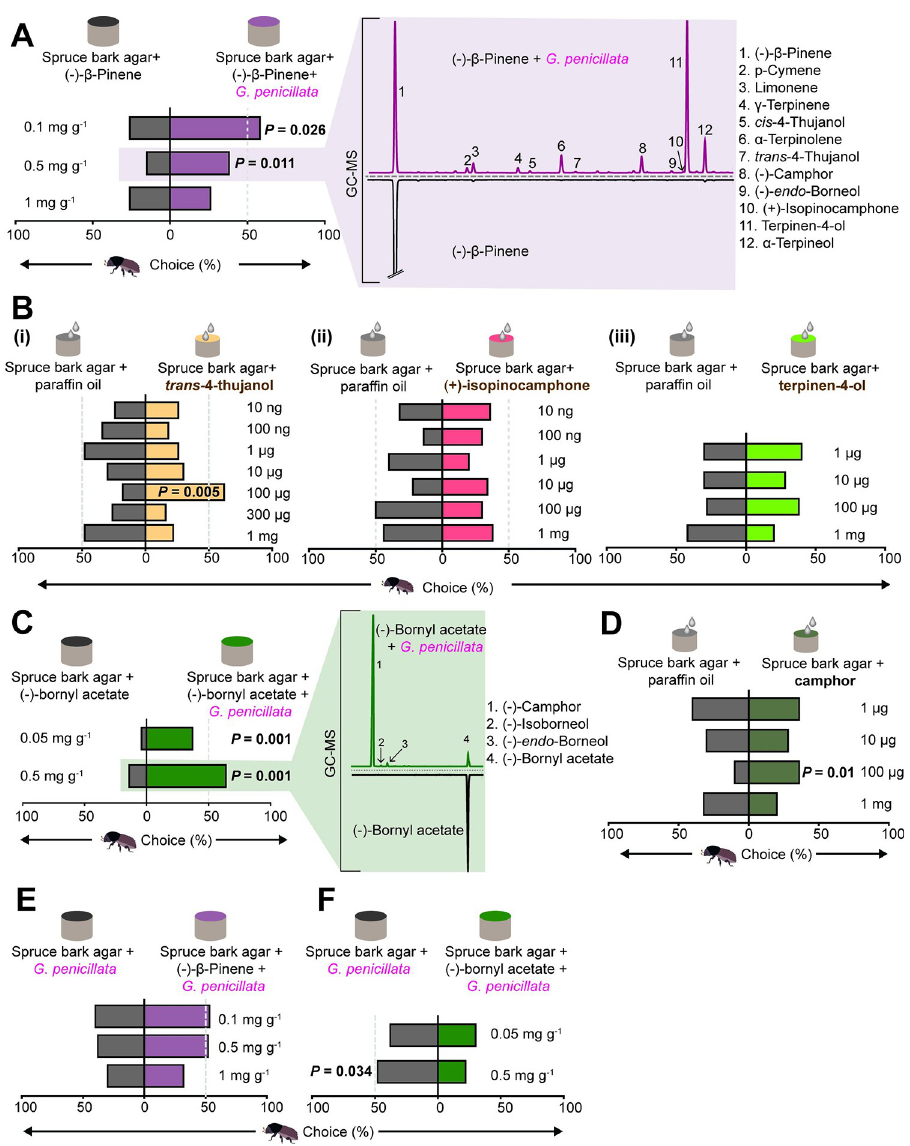
Fig 6. Ips typographus is attracted to a fungal symbiont that produces a blend of oxygenated monoterpenes. (A) Adult beetles preferred spruce bark agar enriched with 0.1 and 0.5 mg/g of ( − )- β -pineneand inoculated with G . penicillata over spruce bark agar enriched with 0.1 and 0.5 mg/g ( − )- β -pinene alone, but without fungus (left). GC–MS traces depict the headspace volatiles of ( − )- β -pinene-enriched agar left for 4 d with and without G . penicillata (right) and show several oxygenated monoterpenes produced by the fungus from ( − )- β -pinene.Numbers refer to the identities of compounds. (B) Adult beetles chose trans -4-thujanol (left) at a 100- μ g dose diluted in mineral oil, when tested against a mineral oil control (Bonferroni adjusted significance level, α = 0.007). Adult beetles showed indifferent responses to (+)-isopinocamphone (middle), and terpinen-4-ol (right), applied in various doses in mineral oil. (C) Adult beetles preferred spruce bark agar enriched with various amounts of ( − )-bornyl acetate and inoculated with G . penicillata over spruce bark agar enriched with ( − )-bornyl acetate but without fungus (left). GC–MS traces depict the headspace volatiles of 0.5 mg/g ( − )-bornyl acetate-enriched agar left for 4 d with and without G . penicillata (right) and show several oxygenated monoterpenes produced by the fungus from ( − )-bornyl acetate. Numbers refer to the identities of compounds. (D) Adult beetles preferred ( ± )-camphor at a 100- μ g dose against a mineral oil control, but not at other doses (Bonferroni adjusted α = 0.012). (E) Adult beetles did not discriminate between G . penicillata on agar with three different concentrations of ( − )- β -pinene and G . penicillata without ( − )- β -pinene. (F) Adult beetles chose G . penicillata on agar without any administrated ( − )-bornyl acetate vs. G . penicillata on agar with 0.5 mg/g ( − )-bornyl acetate. (A–F) Deviation of response indices against zero was tested using Wilcoxon’s test. n = 25 or 50 for each trial. The data underlying this Figure can be found at